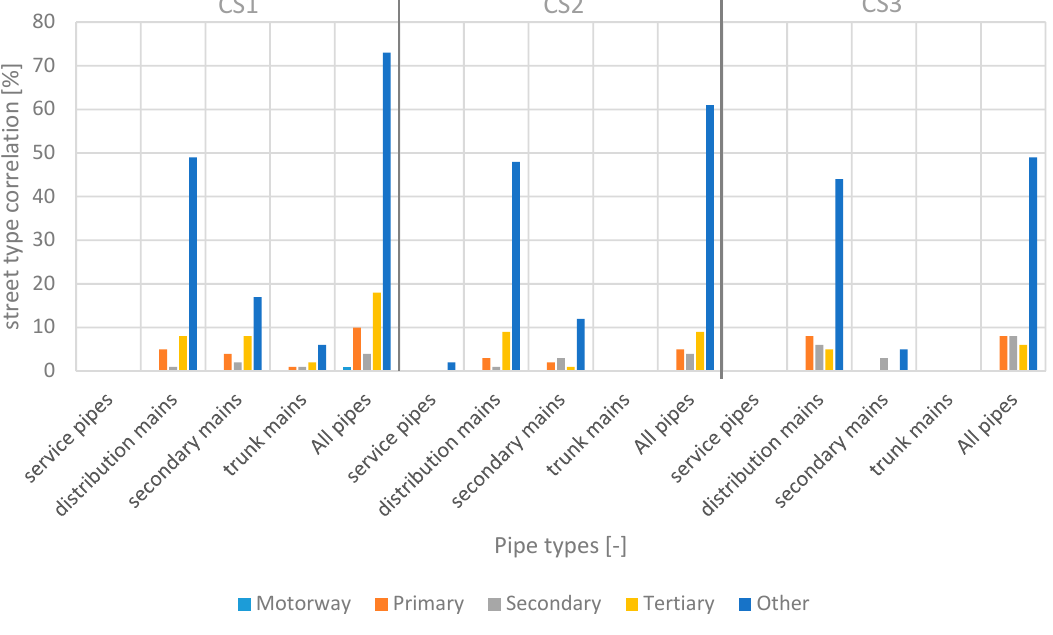
Figure 6. Pipe types in correlation with street types.